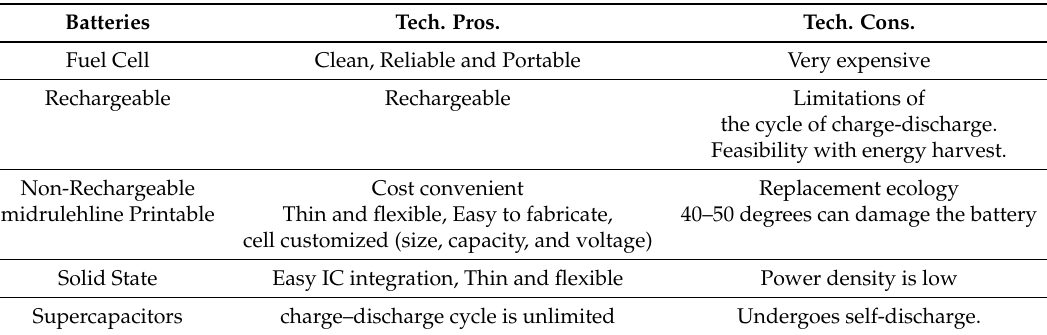
Table 4. Energy storage devices [127–129].